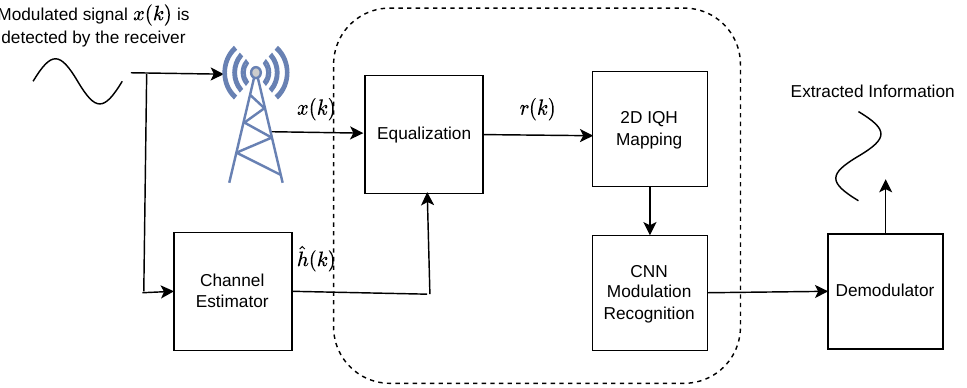
Figure 1. The conceptual diagram of the proposed